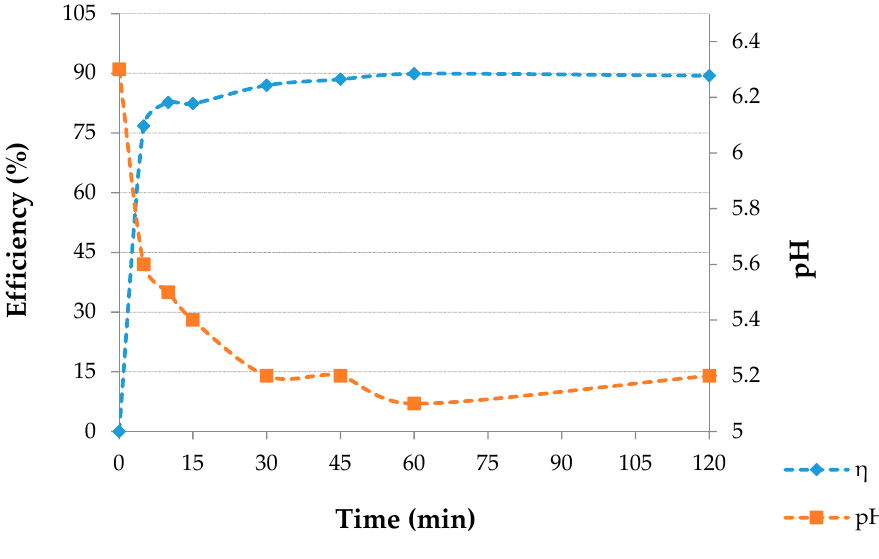
Figure 2. Dependence of sorption efficiency η and changes of pH on time during